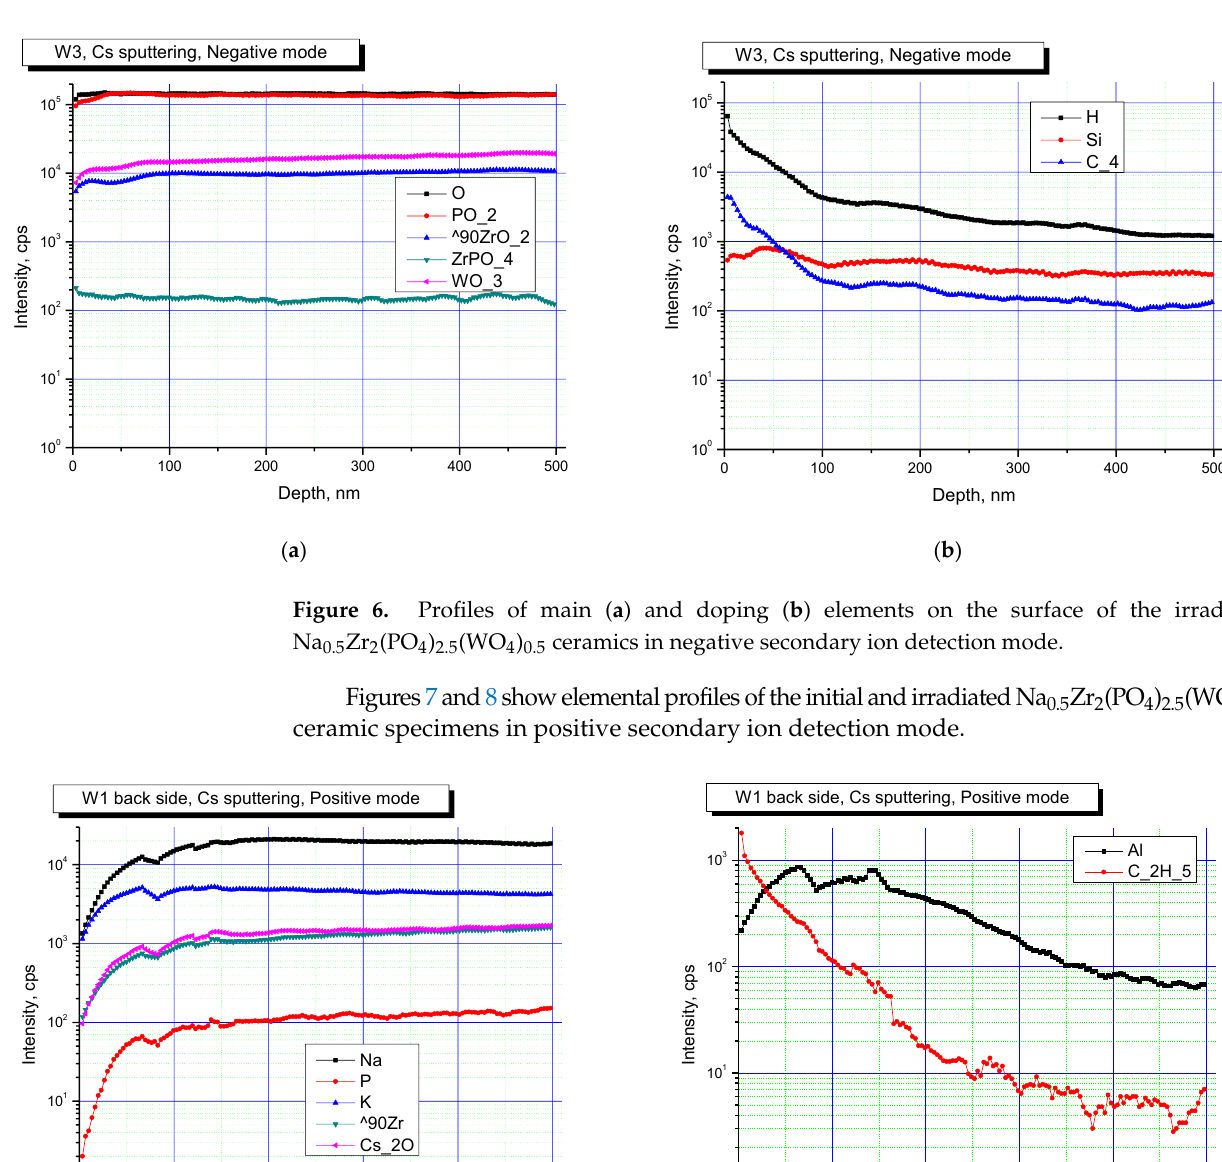
Figure 6. Profiles of main ( a ) and doping ( b ) elements on the surface of the irradiated Na 0.5 Zr 2 (PO 4 ) 2.5 (WO 4 ) 0.5 ceramics in negative secondary ion detection mode.